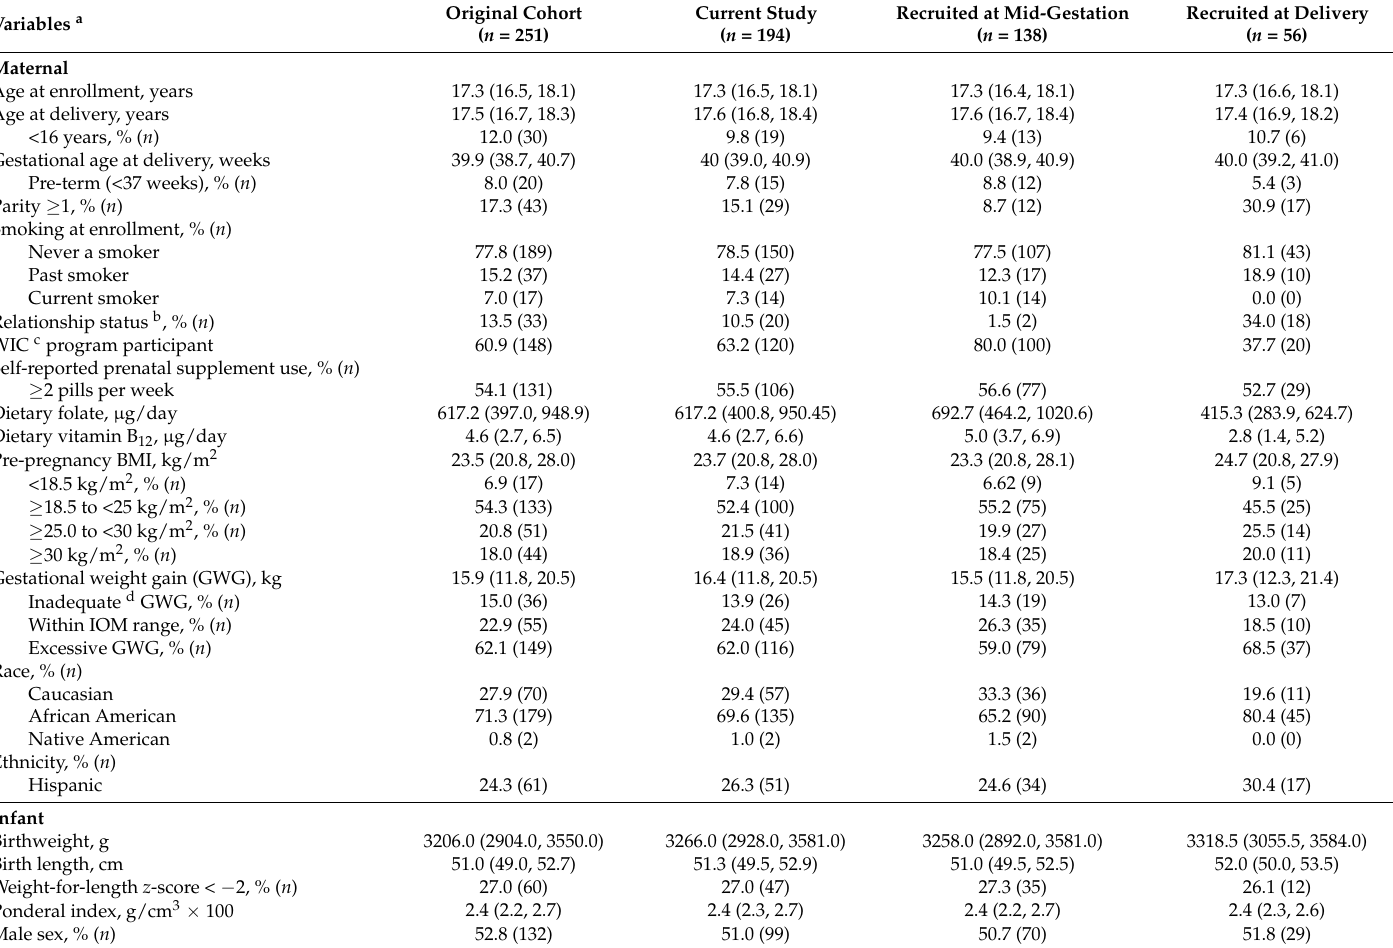
Table 1. Characteristics of the study